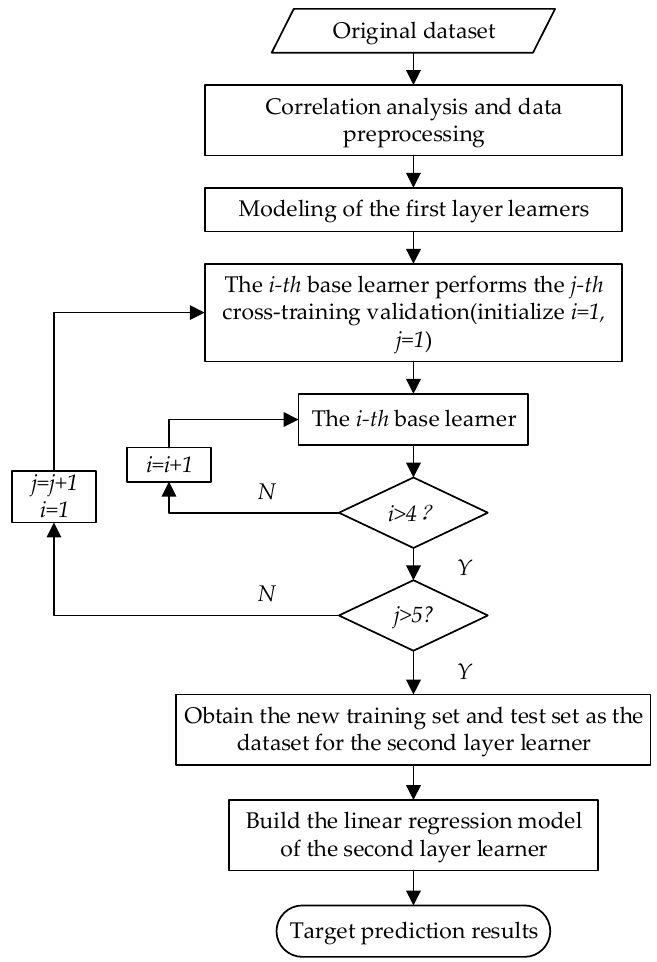
Figure 3. The flowchart of the stacking